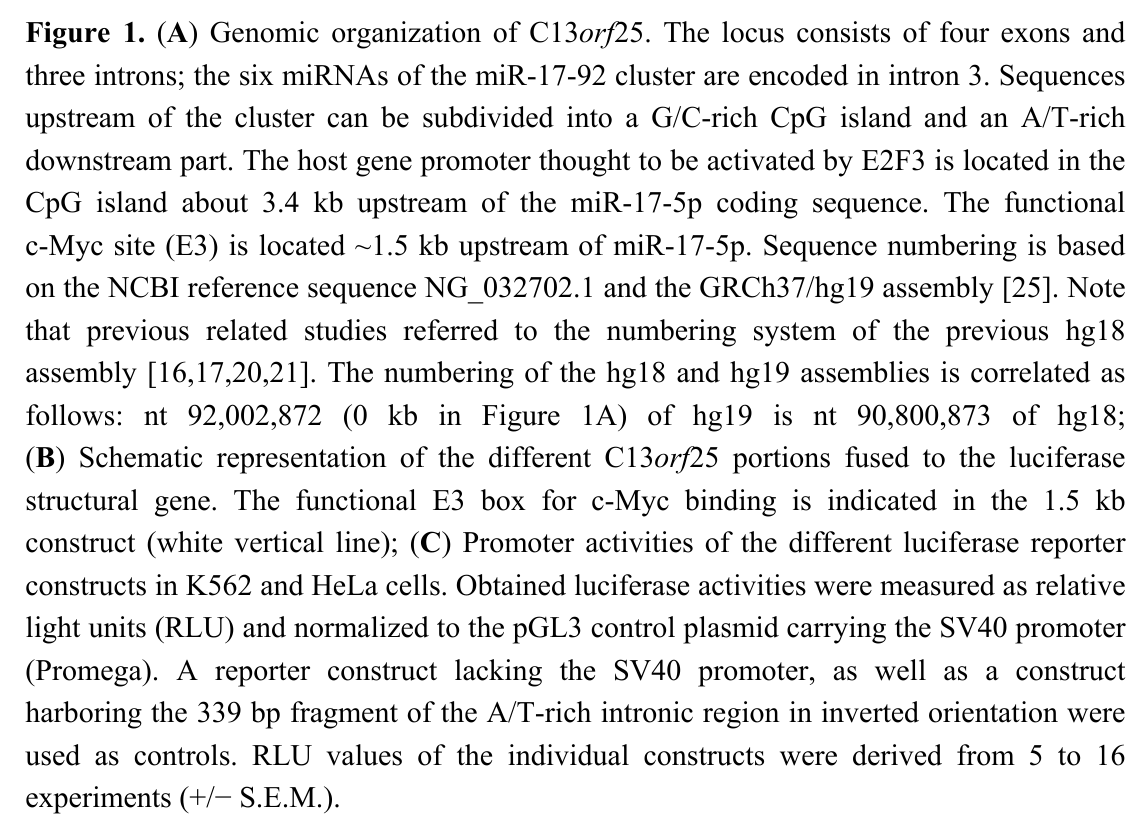
Figure 1. ( A ) Genomic organization of C13 orf 25. The locus consists of four exons